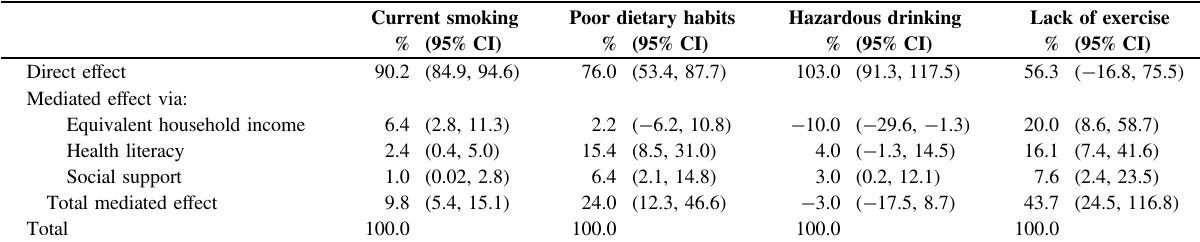
Table 3 Proportions of the direct and indirect e ff ects on the association between education and health-related behaviors Current smoking Poor dietary